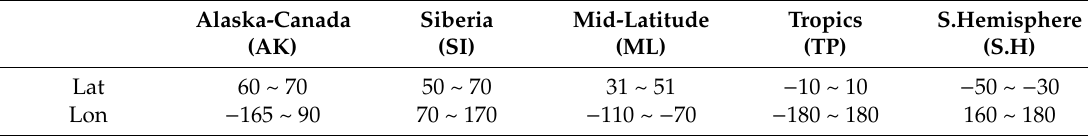
Table 1. List of regions used to calculate the average of AIRS CH 4.